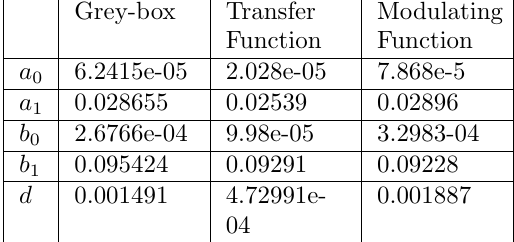
Table 1: Summary of estimated parameters Grey-box Transfer Modulating Function